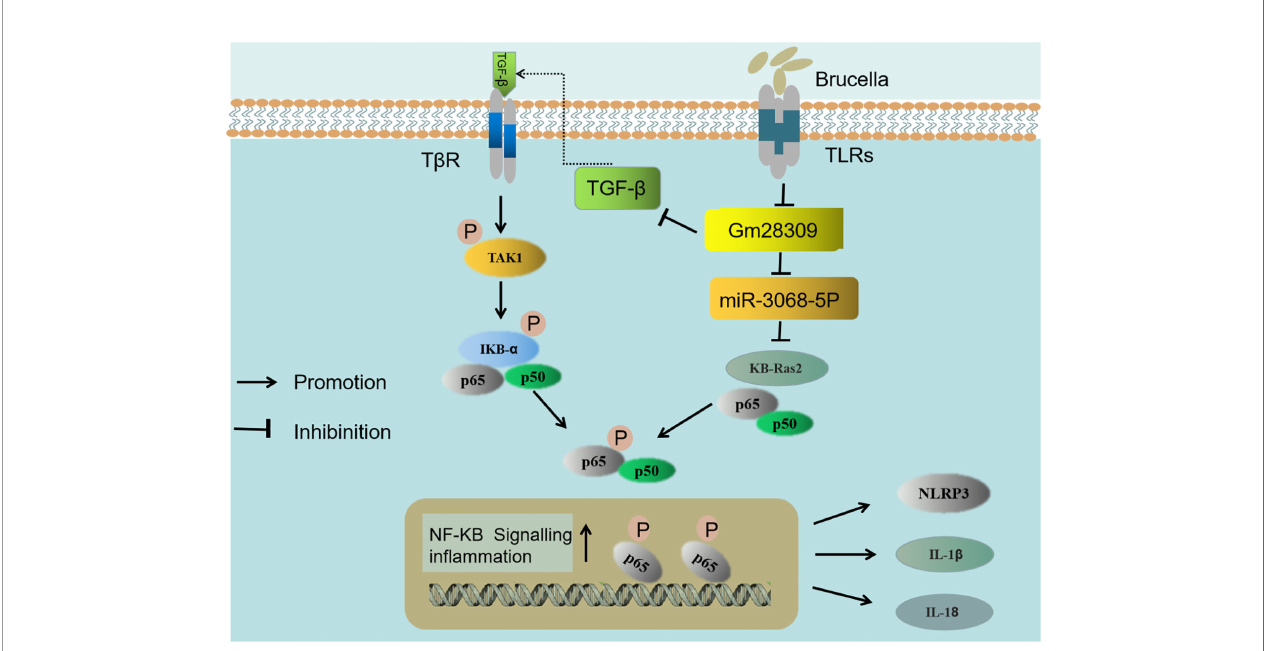
FIGURE 7 | Schematic representation of the proposed model of Gm28309 role in in fl ammation response. The recognition of Brucella by TLRs located on the host cell membrane repressed the expression of lncRNA Gm28309. The decrease of Gm28309 has two effects, both resulting in the activation of the NF- k B pathway: On one side, expression of TGF- b is promoted, leading to a cascade of TAK1 and IKK kinases promoting p65 phosphorylation. On the other side, miR-3068-5p, which is normally sponged by Gm28309, is released in the cytoplasm, where it targets k B-Ras2 for degradation, thereby inducing p65 phosphorylation. The activation of the NF- k B pathway promotes the assembly of the NLRP3 in fl ammasome and the secretion of IL-1 b and IL-18 to intracellular bacterial